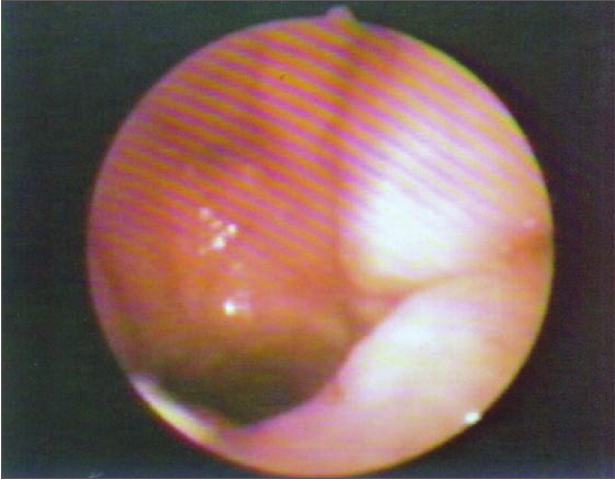
Figura 1. Paciente 1: fechamento do EVF em registro